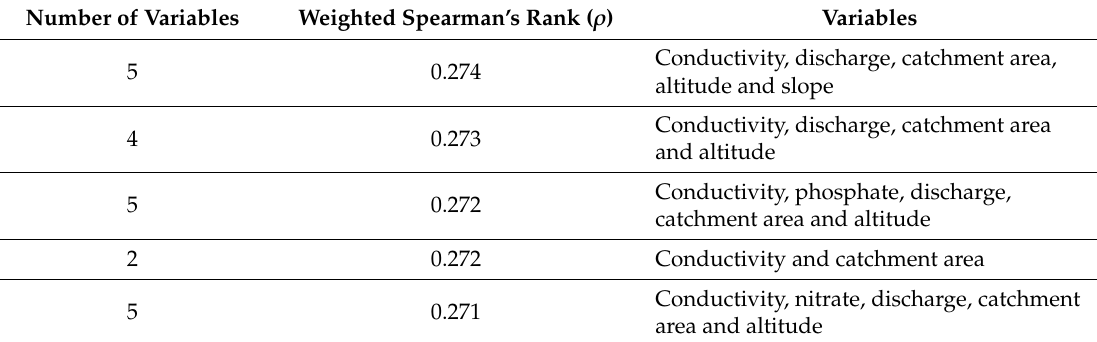
Table 5. Weighted Spearman’s rank correlation between the biotic and abiotic variables using the BIOENV